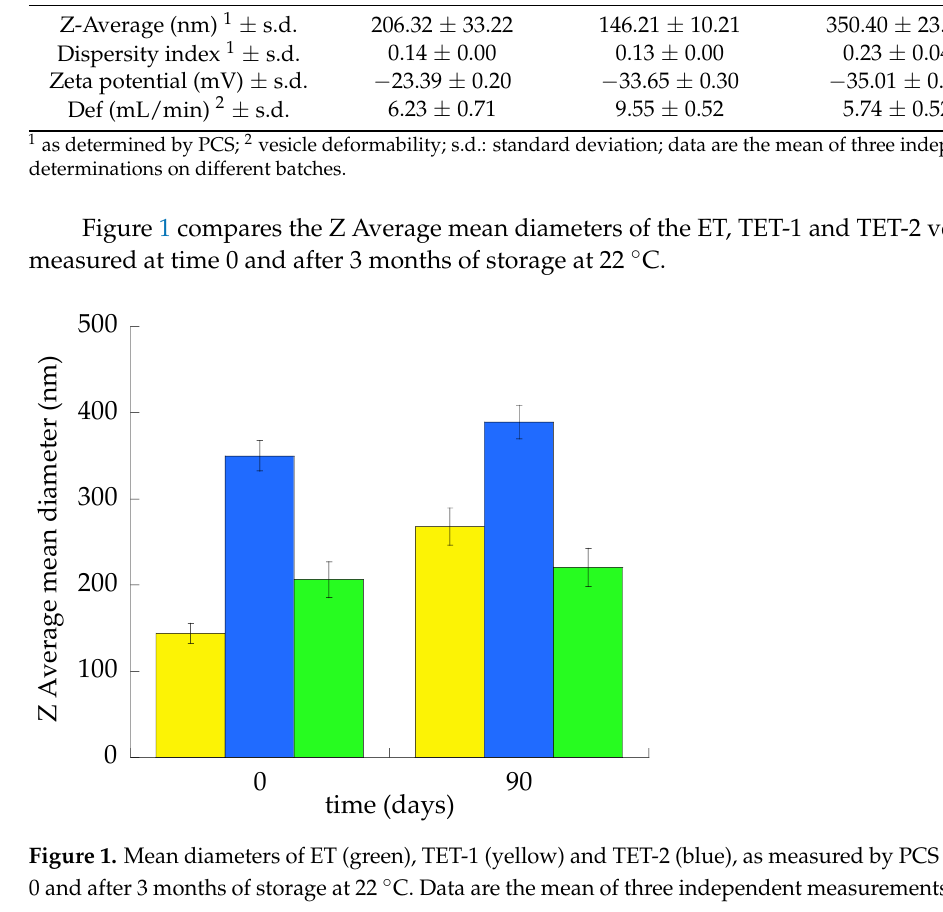
Table 2. Size distribution parameters, zeta potential and deformability of nanovesicular systems. Parameters ET TET-1 TET-2 Z-Average (nm) 1 ± s.d. 206.32 ± 33.22